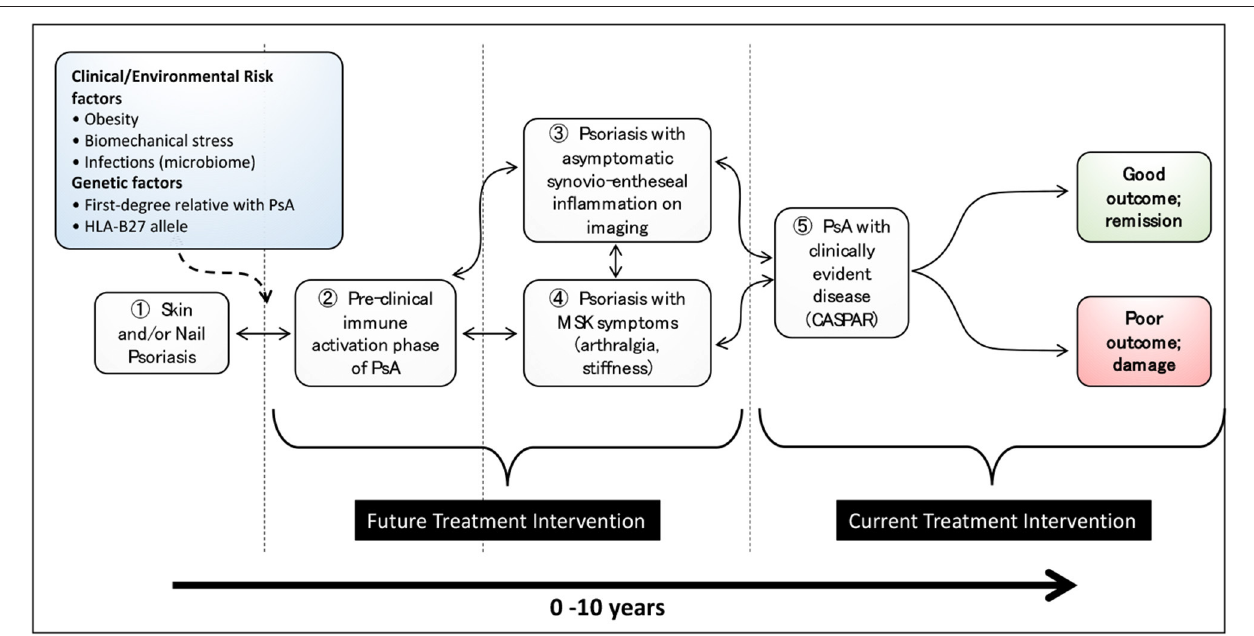
FIGURE 1 | Stages in the development of psoriatic arthritis in patients with psoriasis (from Nature Reviews Disease Primer on Psoriatic Arthritis; accepted, in editorial review where figure has been re-drawn).